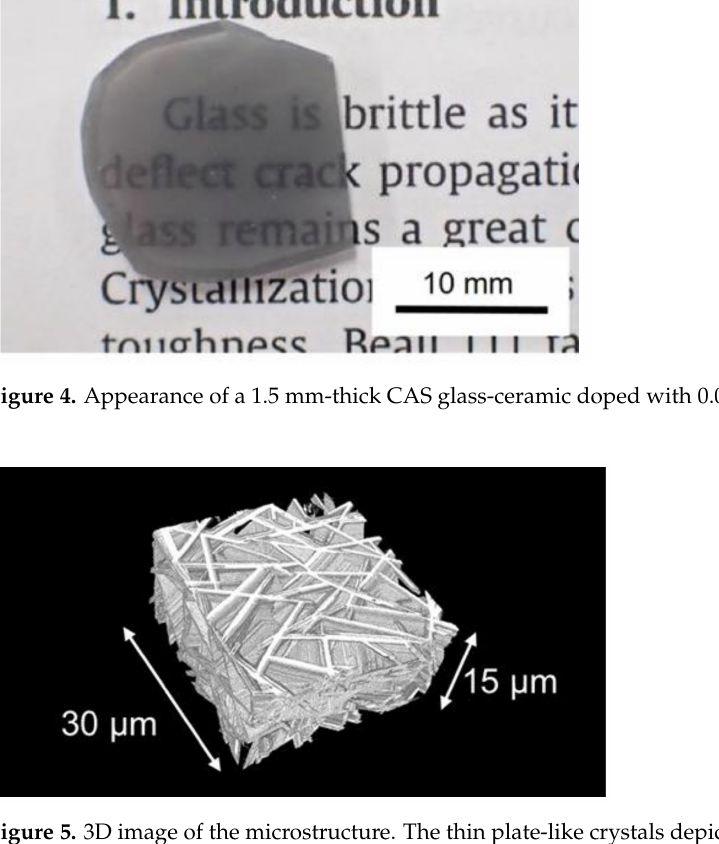
Figure 5. 3D image of the microstructure. The thin plate-like crystals depicted in white color form a house-of-cards structure